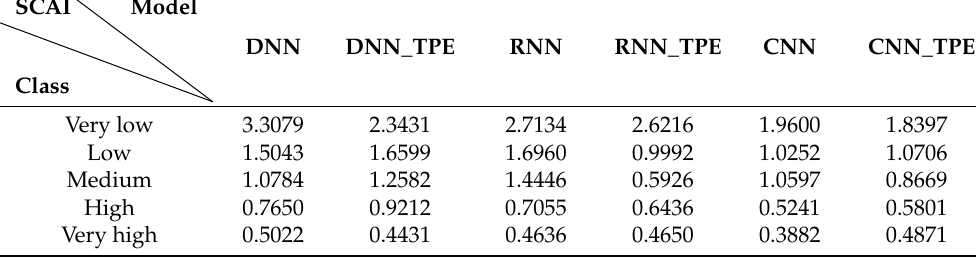
Table 6. The SCAI results of three typical neural network models before and after TPE optimization.